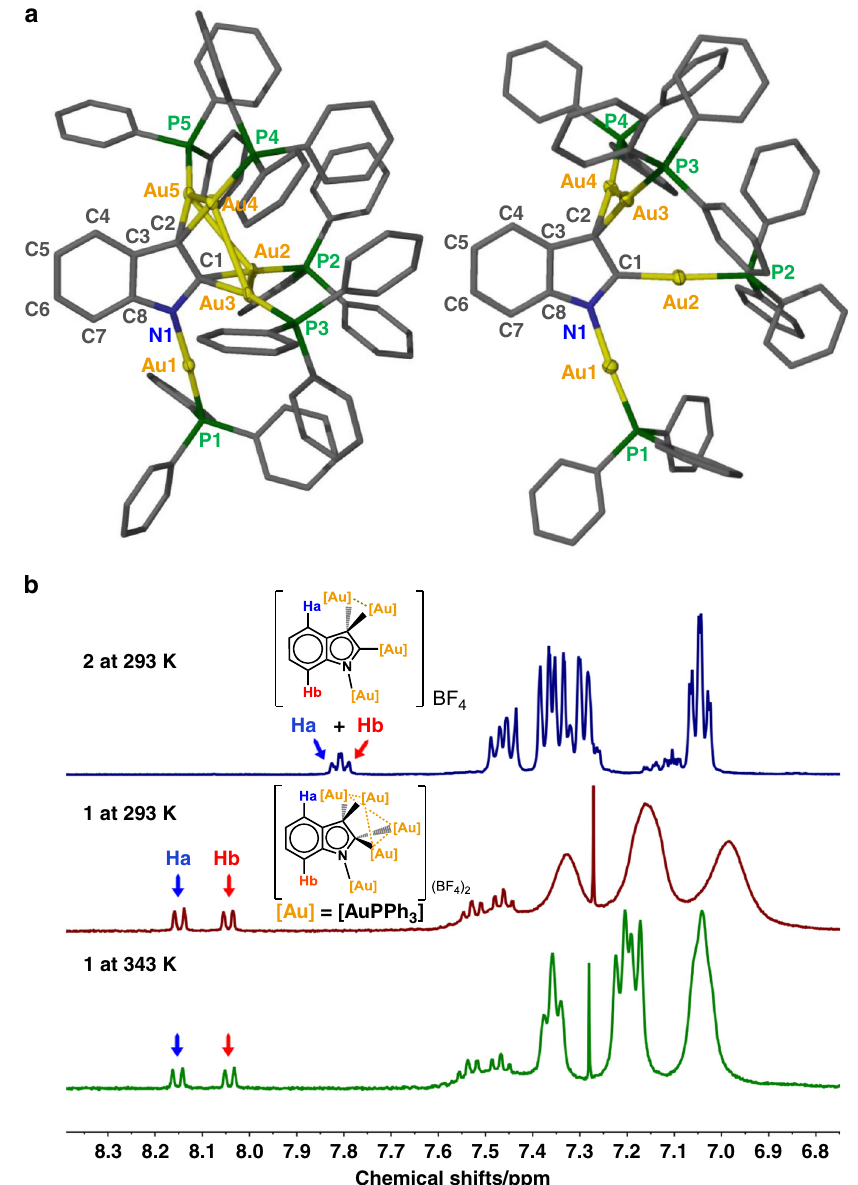
Fig. 3 Crystal structures and 1 H-NMR spectra of 1 and 2. a Crystal structures of 1 (left) and 2 (right). Hydrogen atoms and tetra fl uoroborate counter anions are omitted for clarity. Selected bond lengths (Å) and angles (°) in 1 : N1 – C1 1.375(9), C1 – C2 1.426(11), C2 – C3 1.434(9), C3 – C8 1.415(10), C8 –